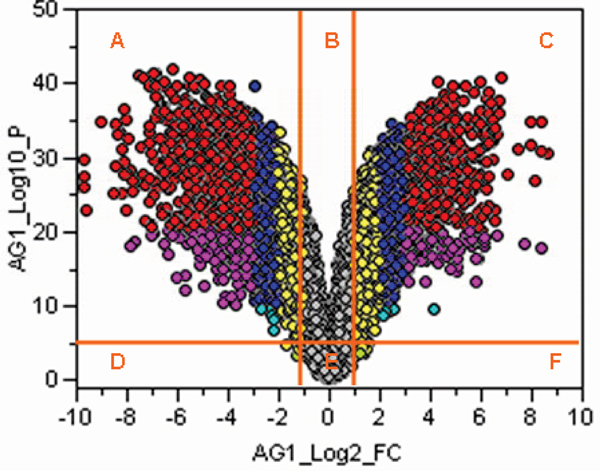
Volcano plot illustration of joint FC and P gene selection rule. Genes in sectors A and C are selected as differentially expressed. The colors correspond to the negative log10 P and log2 fold change values: Red: 20 < -log10 P < 50 and 3 < log2 fold < 9 or -9 < log2 fold < -3. Blue: 10 < -log10 P < 50 and 2 < log2 fold < 3 or -3 < log2 fold < -2. Yellow: 4 < -log10 P < 50 and 1 < log2 fold < 2 or -2 < log2 fold < -1. Pink : 10 < -log10 P < 20 and 3 < log2 fold or log2 fold < -3. Light blue: 4 < -log10 P < 10 and 2 < log2 fold or log2 fold < -2. Light green: 2 < -log10 P < 4 and 1 < log2 fold or log2 fold < -1. Gray)